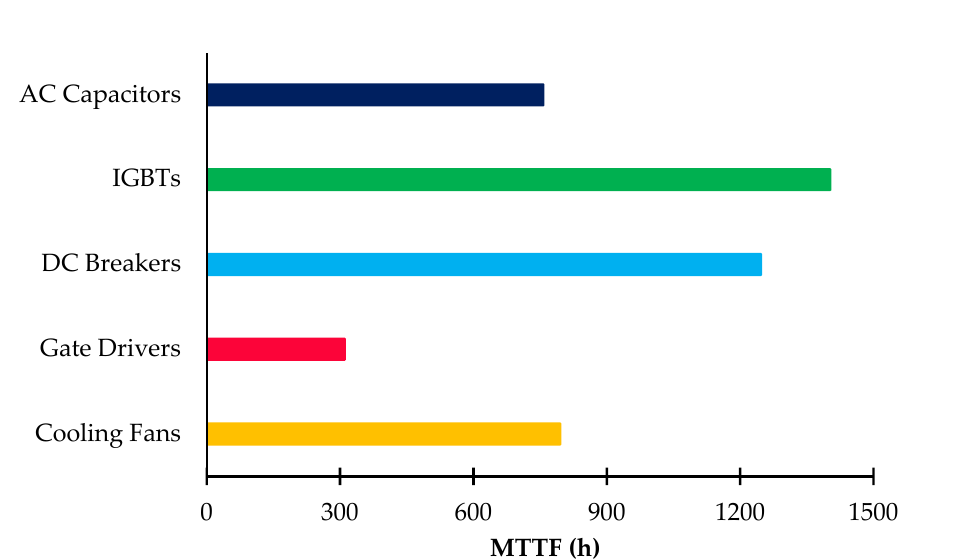
Figure 5. Mean Time To Failure ( MTTF ) of the DC/AC converter components evaluated using data from literature.